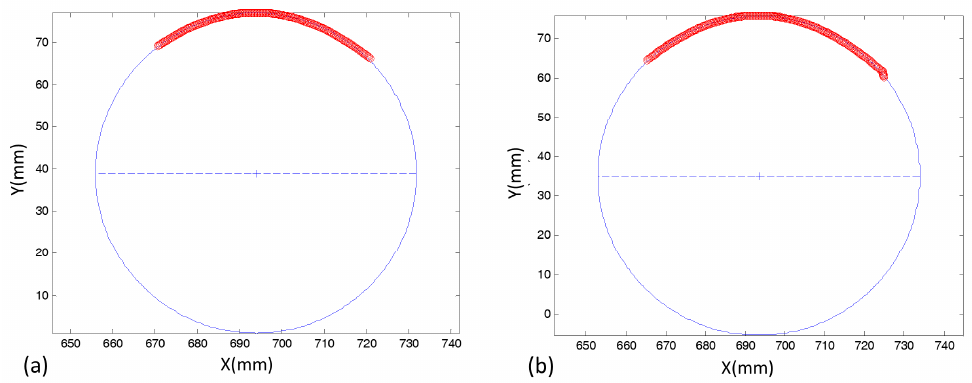
Figure 11. Circle fitting in the textured areas: ( a ) above the strip and ( b ) below the strip.